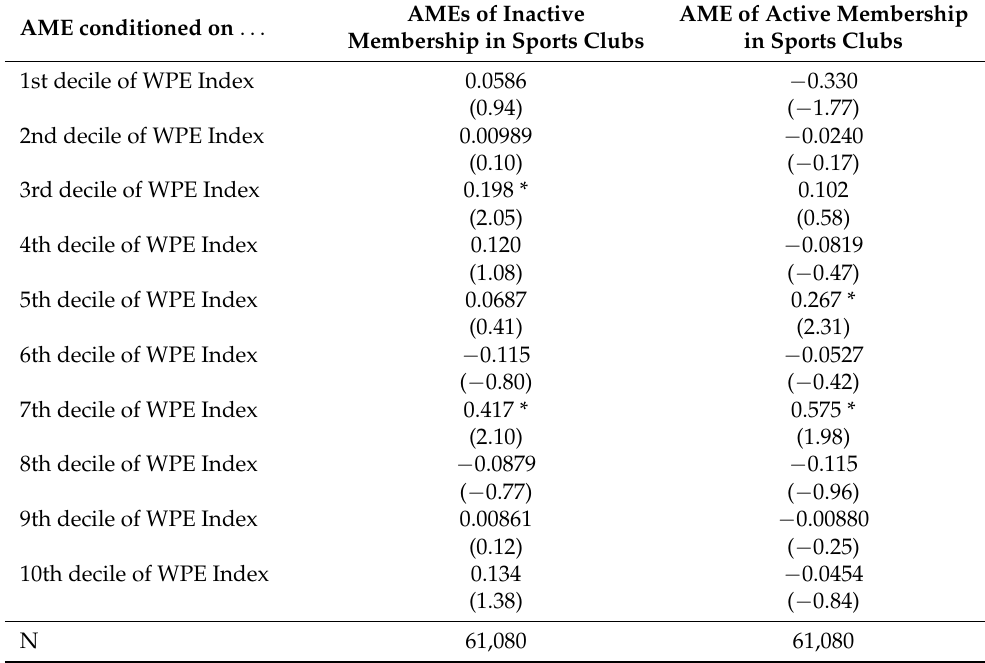
Table A9. Average marginal effects (AMEs) from inactive and active membership in sports clubs on sexist gender ideologies conditioned on the deciles of the WPE Index. Results for the group of women. We included 95% confidence intervals using robust standard errors. Source: WVS-EVS-data and V-Dem data.